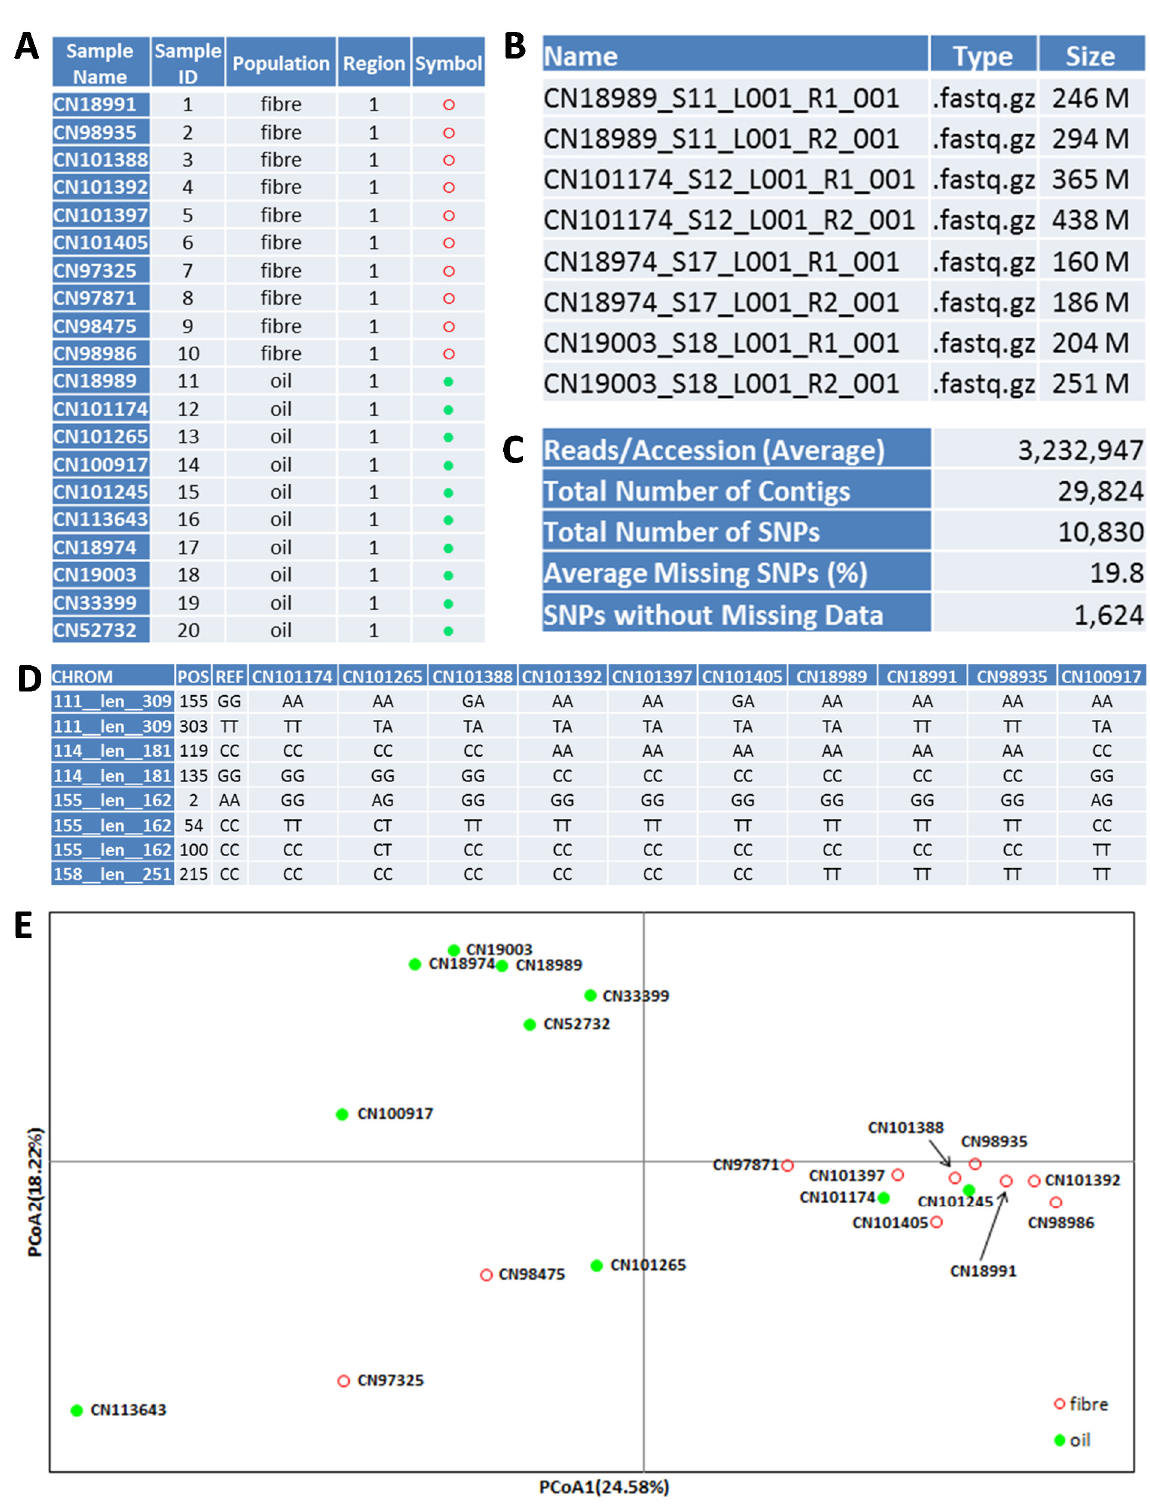
Figure 3. An illustration of 20 flax samples ( A ) and their GBS application outputs: FASTQ file names and sizes ( B ), major bioinformatics analysis outcomes ( C ), SNP genotypes ( D ) and a PCoA plot for sample association ( E ). Note that (B) and (D) only show a sample of all files and